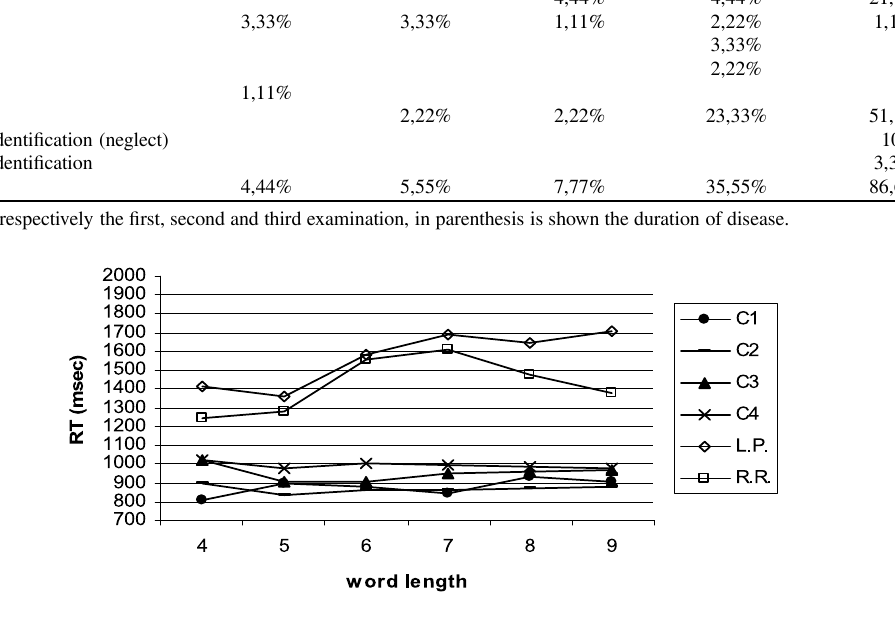
Fig. 1. Response times (msec) of L.P., R.R. and their matched controls as a function of word length. Note that the fi gure reports performances measured at the fi rst examination for both patients corresponding to 8 months from the disease onset for patient L.P. and three years for patient